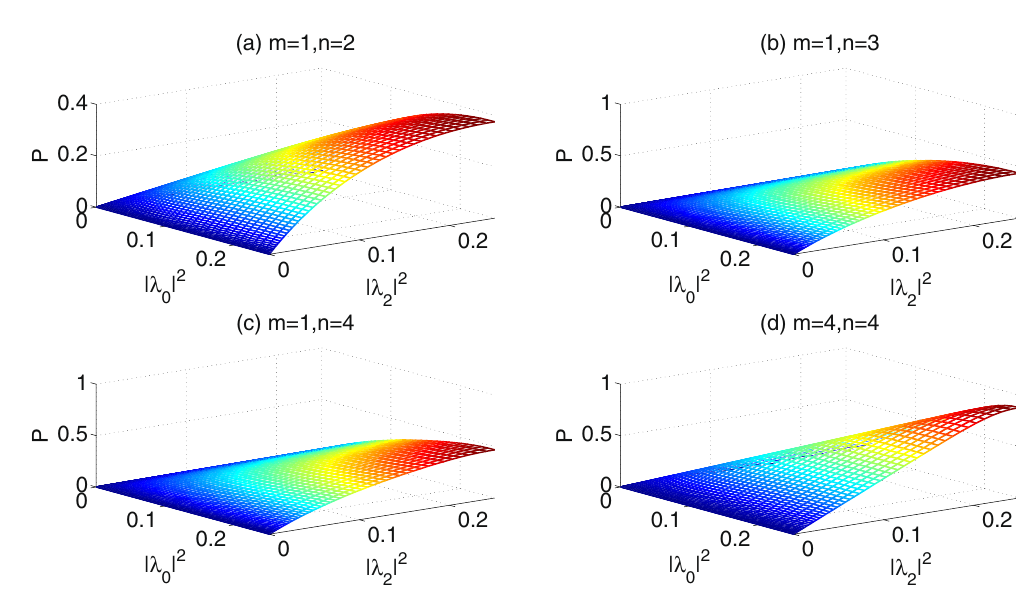
Figure 6. ( a–c ) The success probabilities of the concentration in the second ECP vs the parameters | λ 0 | 2 and | λ 2 | 2 , when the number of Alice’s iterations is fixed as m = 1. ( d ) The success probabilities when both of m and n are equal to